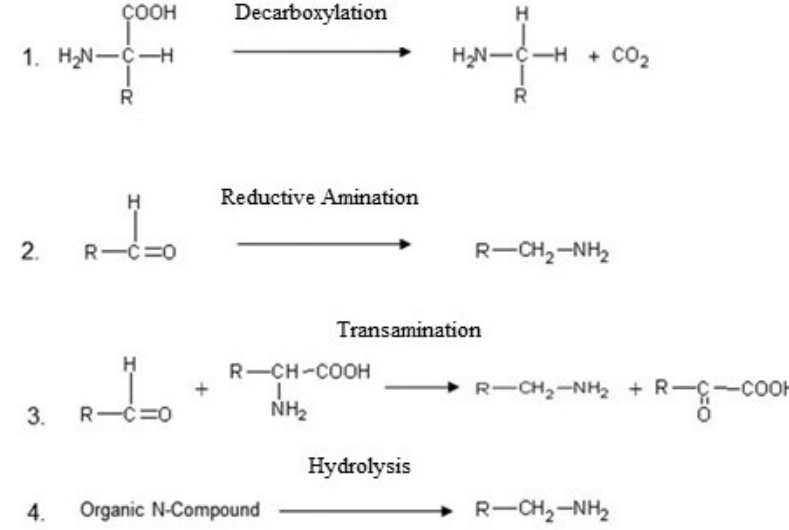
Figure 2. Formation of biogenic amines by 1. Enzymatic decarboxylation of amino acids, 2. Reductive amination of aldehydes and ketones, 3. Transamination reactions between aldehydes and amino acids and 4. Hydrolytic degradation of organic nitrogen compounds (e.g.,